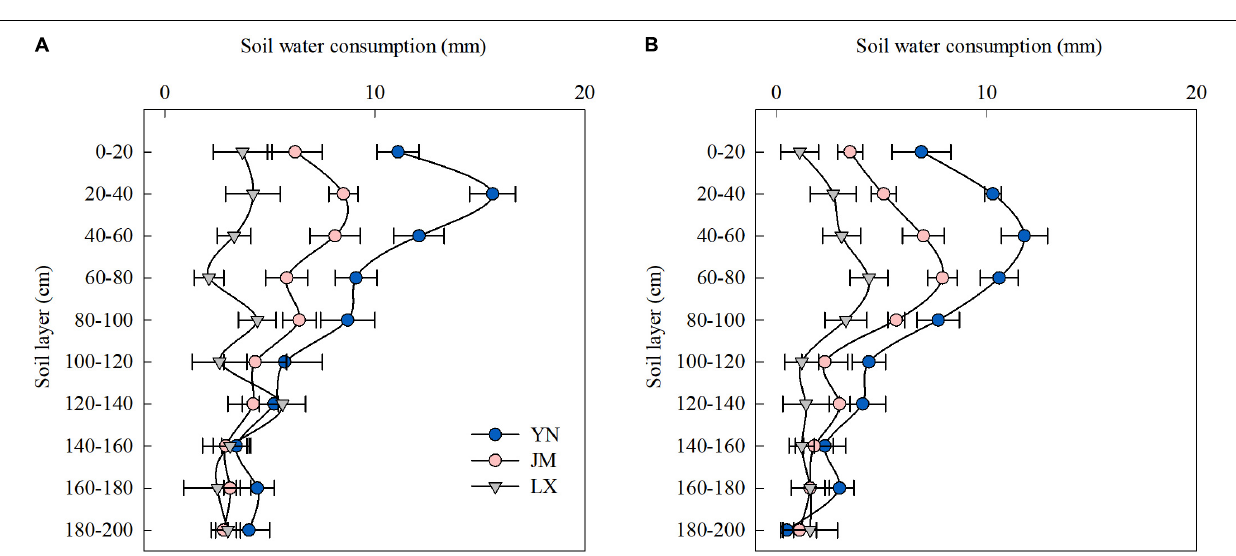
FIGURE 2 | Soil water consumption in the 0–200 cm soil layer from anthesis to maturity of wheat varieties in the 2017–2018 (A) and 2018–2019 (B) growing seasons. YN, Yannong 1212; JM, Jimai 22; LX, Liangxing 99. Vertical bars represent the SD of the